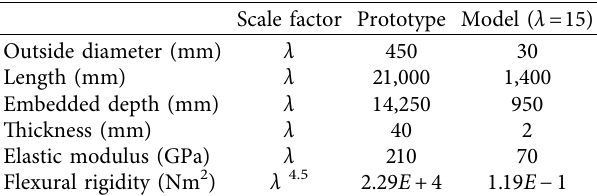
Figure 1: Schematic drawing of the model pile test setup. Table 1: Material properties of the prototype pile and model pile used in this